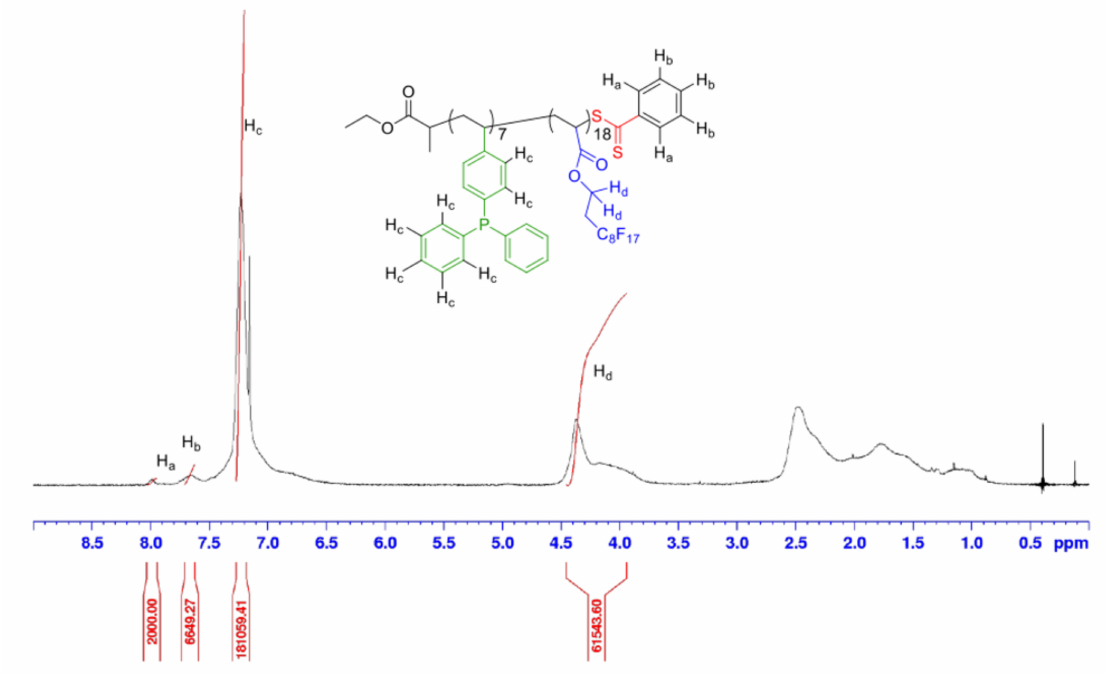
Figure 5. 1 H-NMRspectrum(400MHz, CFC-113+C 6 D 6 capillaries)ofP(DPPS- co -FDA)afterprecipitation. The degrees of polymerization and the molecular weight of the copolymer P(DPPS- co -FDA) were estimated using Equations (S19)–(S21). They were estimated to be equal to M n,precipitated,P(DPPS- co -FDA) = 11,640 g/mol with DP DPPS = 7.5 and DP FDA = 17.8 (Figure 5). P(StySAc- co -FDA) copolymer is slightly soluble in acetone, and soluble in chloroform. Its 1 H-NMR spectrum shows a broad peak between δ = 6.5 and 7 ppm relative to the aromatic protons of the StySAc monomer (Figure